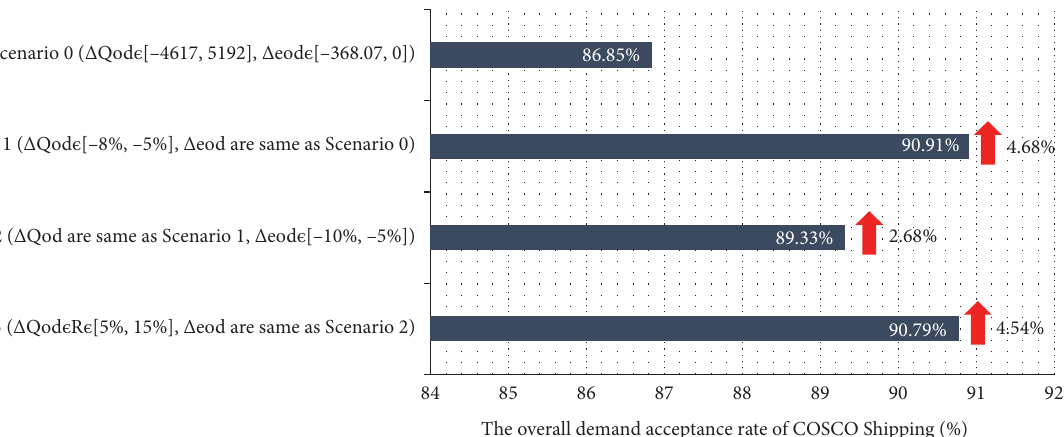
Figure 8: The overall demand acceptance rate of COSCO Shipping in Scenarios